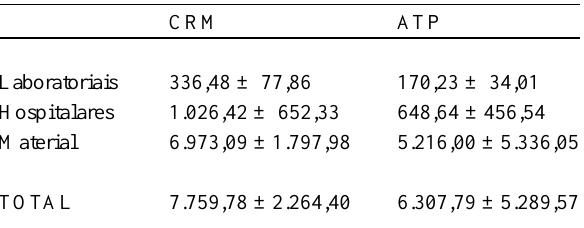
Tabela 4. Custos (R$), por procedimento, de internamento, para o subgrupo